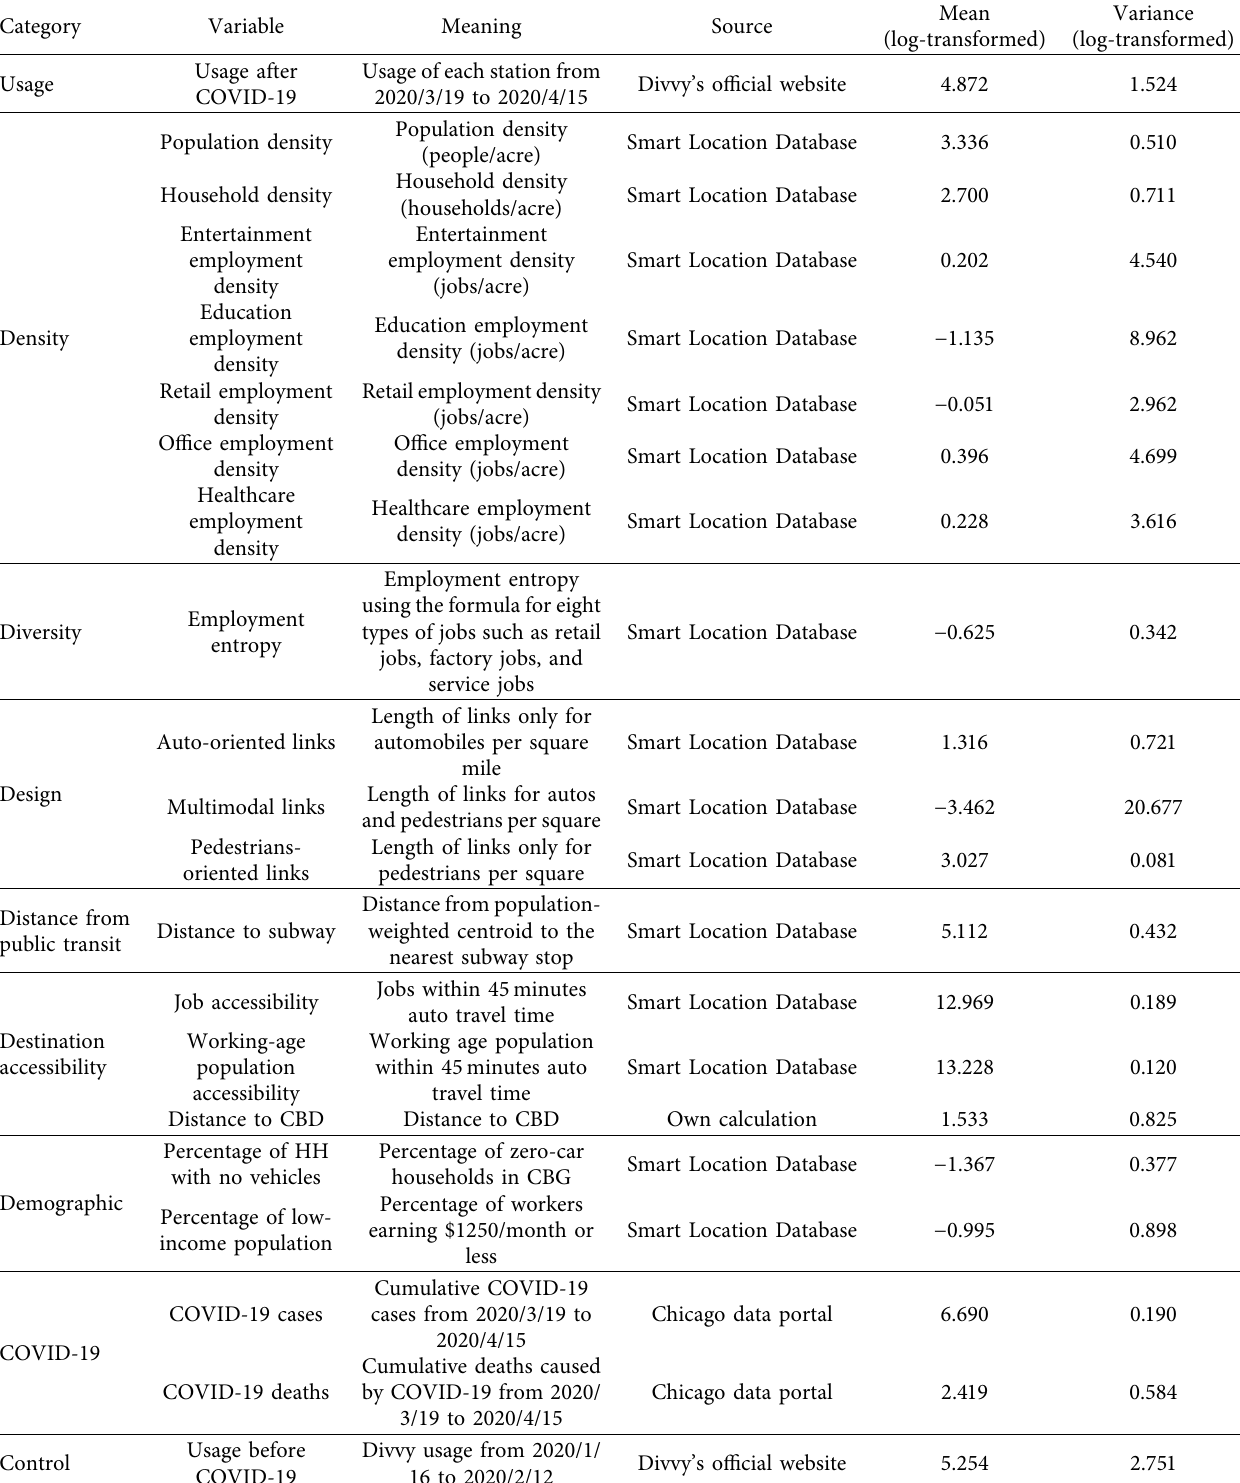
Table 2: Descriptive statistics of